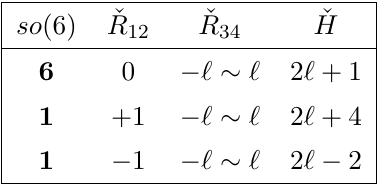
Table 2 . Scalar modes on an M2-brane wrapped on z 1 = 0 . ‘ = 0 , 1 , 2 , . . . is the orbital angular momentum in S 2 . States with ( R 12 , R 34 ) = ( − 1 , ‘ ) saturate the BPS bound ˇ H ≥ 2( ˇ R 12 + ˇ R 34 ) . The index i M2 for the other configuration z = 0 is obtained from (3.21) by the Weyl 2 z 2 =0 reflection ˇ u → ˇ u − 1